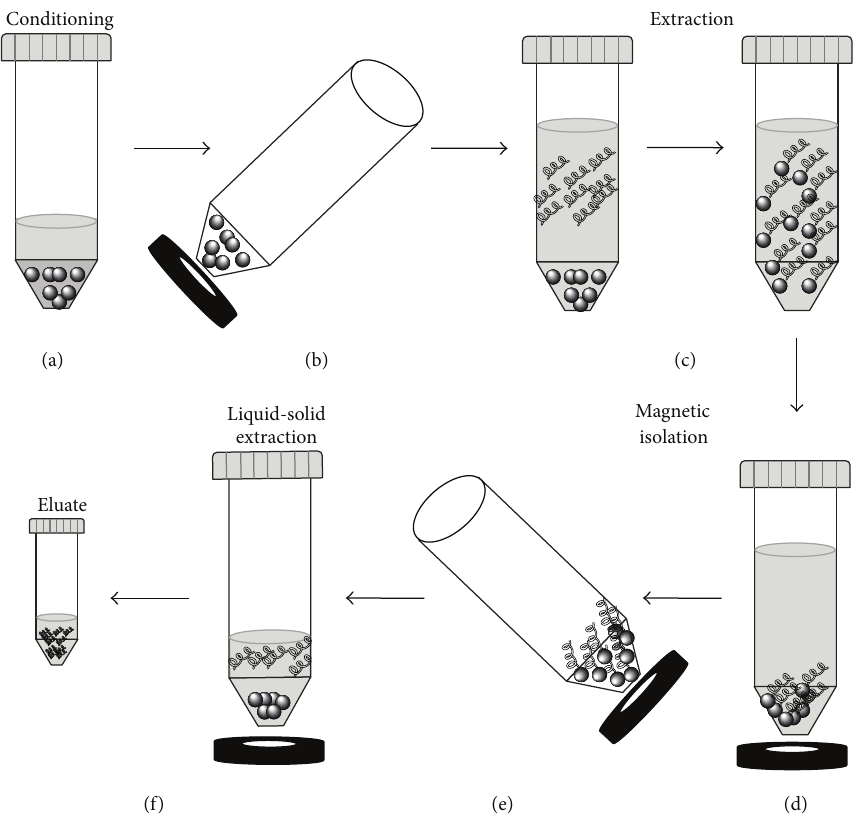
Figure1:SchematicprocedurefortheisolationofseveralanalytesfromfoodsamplesusingMSPE:(a)conditioningofmagneticadsorbent,(b) magnetic isolation, wash, and decantation, (c) extraction of the analytes, (d) magnetic isolation of the adsorbent with the adsorbed analytes, (e) decantation and wash of the magnetic adsorbent, and (f) elution of the analytes (liquid solid